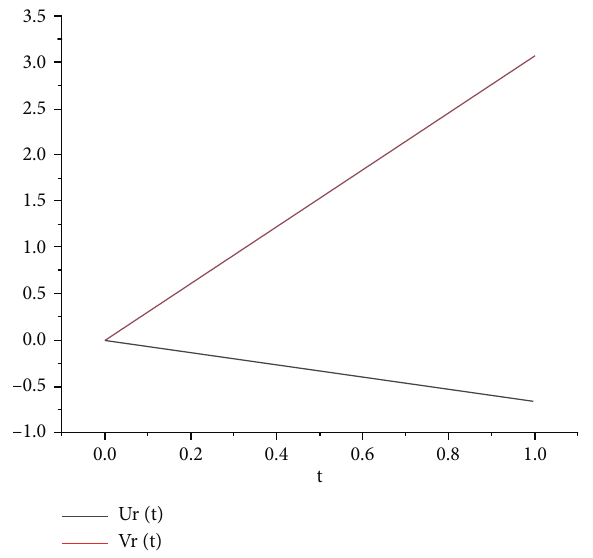
Figure 3: Graphical solution of the Example 23 for the function s ð t Þ = 4 + 6 t + 8 t 2 + 1/t